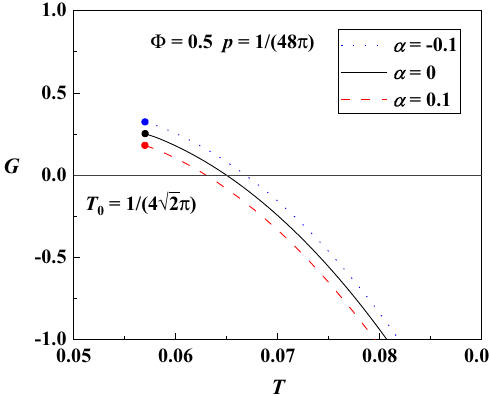
Fig. 9 The HP phase transition temperature of the RN–AdS black holes with the GB term as a function of pressure, with Φ = 0 . 5 and different values of α . T HP decreases with α at a given pressure, and there are terminal points in the coexistence lines, both as same as the Schwarzschild–AdS case in Fig. 4